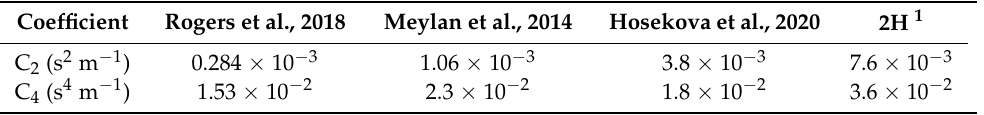
Table 1. Coefficients used in SWAN to model sea ice/wave interactions. Hereafter, the sets of coefficients will be referred to by the bold